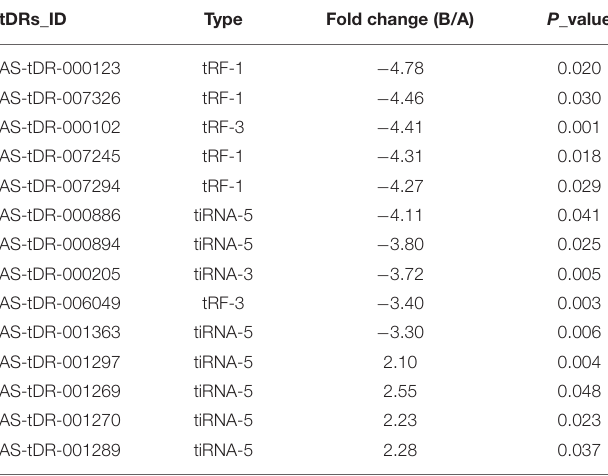
TABLE 3 | The general condition of patients between the two